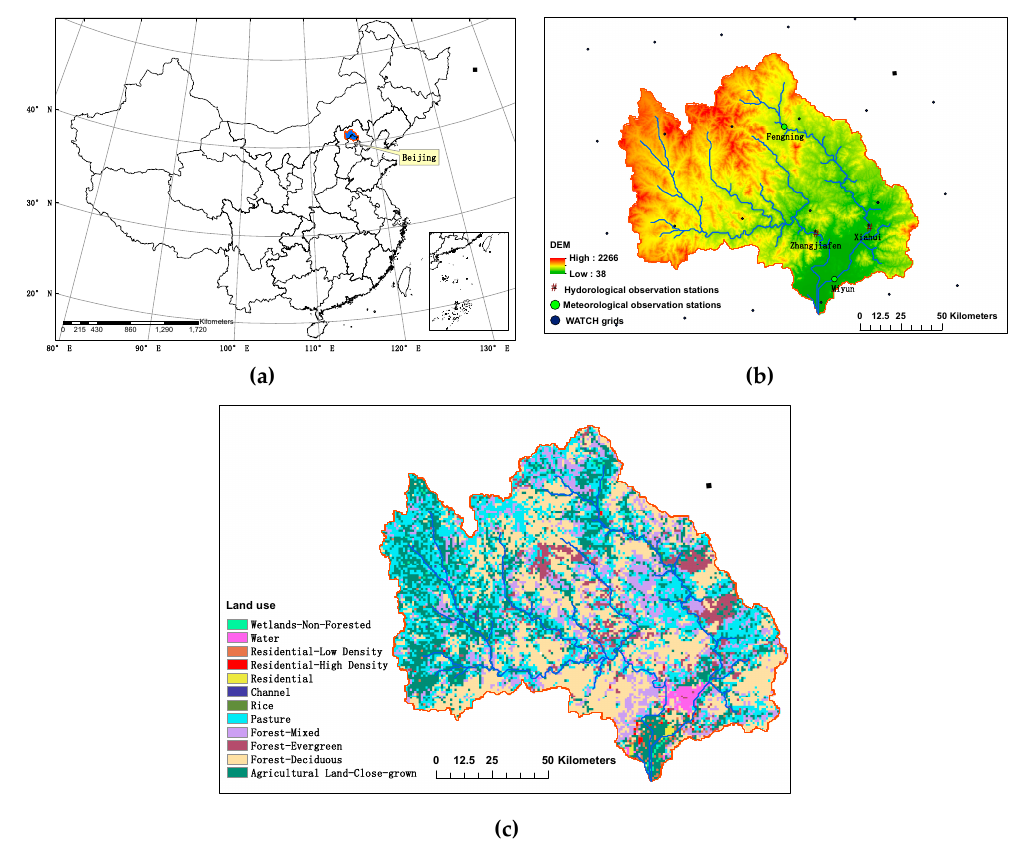
Figure 1. ( a ) Location of the CRB in China; ( b ) overview map of the CRB, DEM (shade), hydrological gauges (triangles), meteorological stations (green circles), and grid notes of climate forcing (black dots); and ( c ) the land use of the